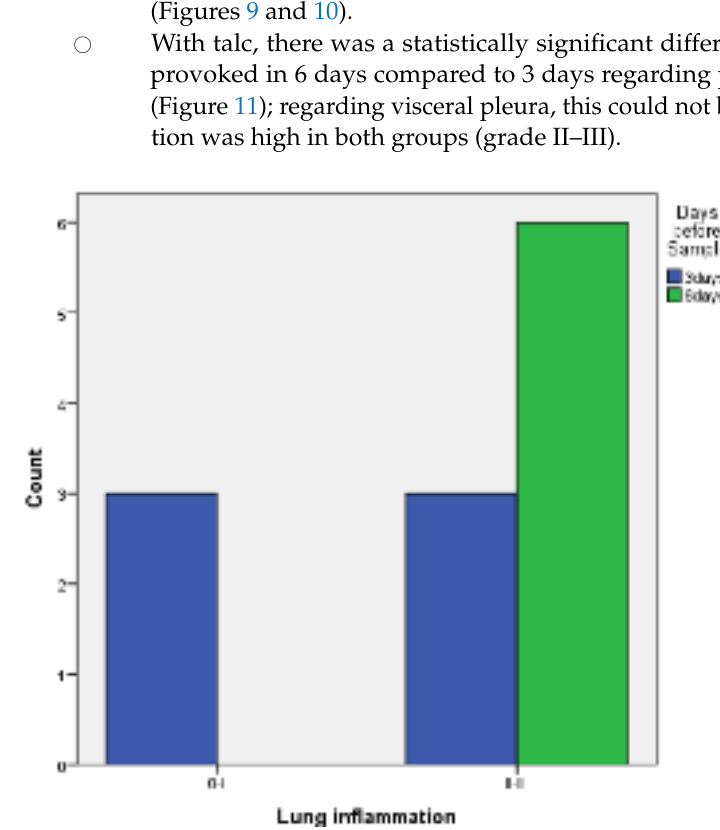
Figure 9. Visceral pleura inflammation 3 vs. 6 days of PRP.